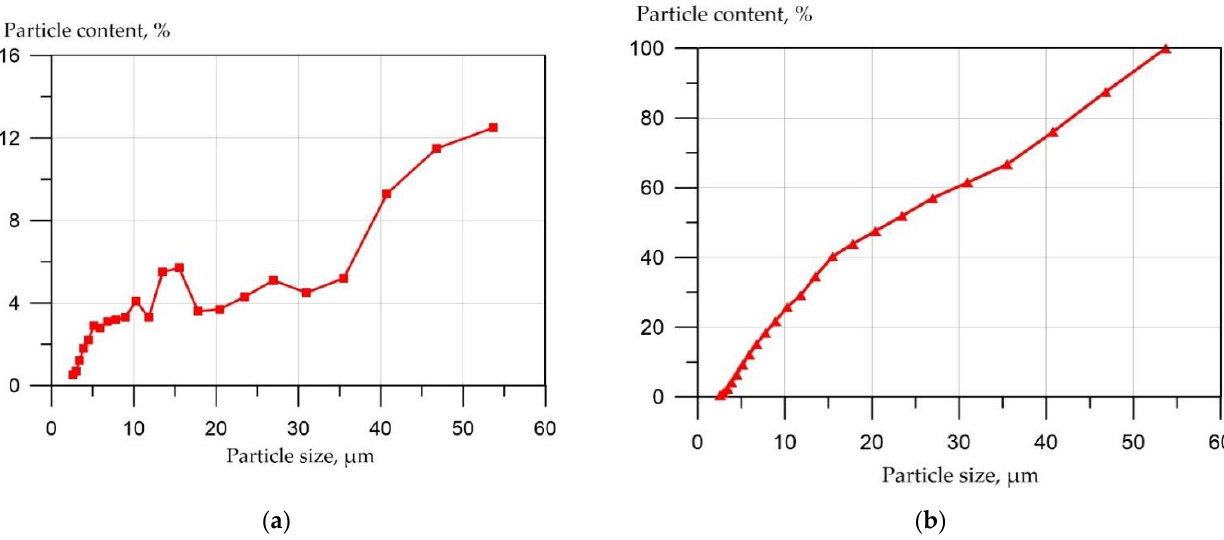
Figure 1. Eggshell Powder Particle Size Distribution Curve: ( a ) particle distribution; ( b ) cumulative curve.